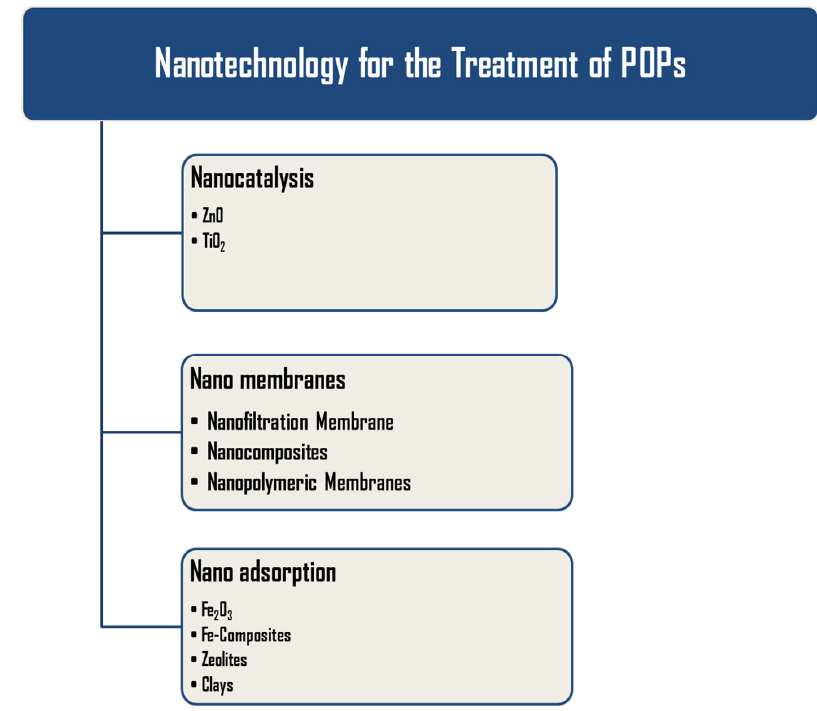
Figure 3. Nanotechnological processes used for the treatment of POPs.